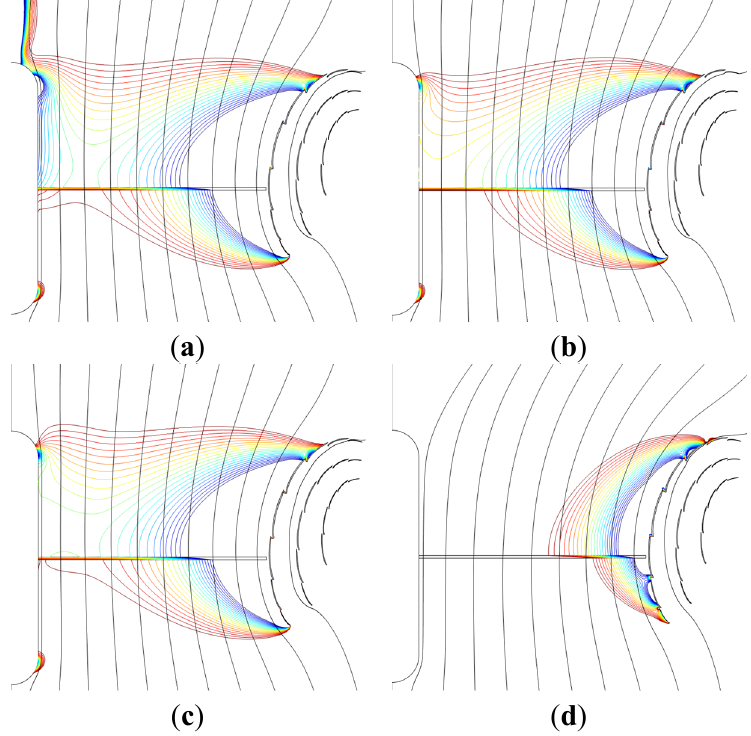
Figure A2. Medium loading: Streamlines and fixed-range selection of pressure contour lines for the multi-element DAWT at a medium C T thrust loading of 0.61. Left plots: TSR = 2. Right plots: TSR = 10. Upper plots: Ideal inner-blade section with constant thrust loading (case 3). Lower plots: Cylindrical inner-blade section with drag and ramped-down thrust loading (case 4). When increasing C T to 0.75 both case 3 rotors (upper) will fall into stall, with deflected flow and power drop as already happened at low loading for case 4 at TSR = 10 ( d ). So, both upper case 3 flows are close to stall. In the low swirl configuration (right), the